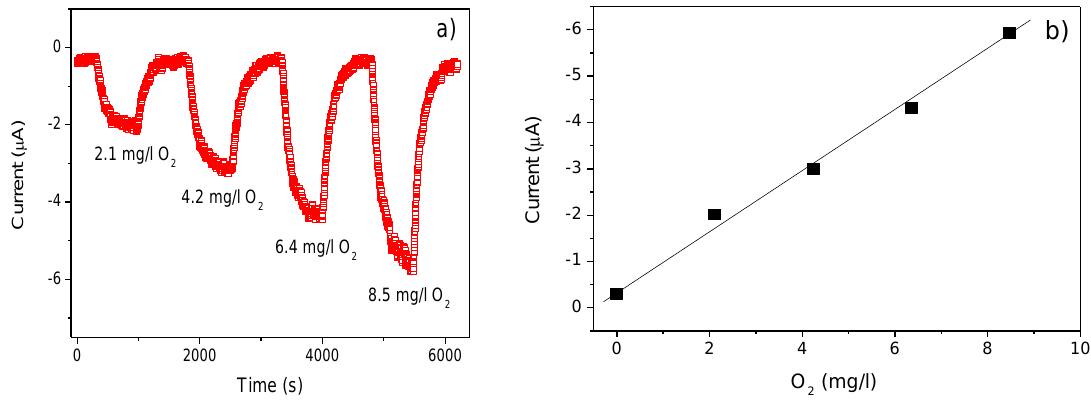
Figure 6. ( a ) Chrono-amperometric test obtained at an applied potential of −0.4 V during cycling saturation and purging of solution by oxygen at different partial pressure between 5% and 20%; ( b ) calibration curve of the sensor for different DO concentrations.